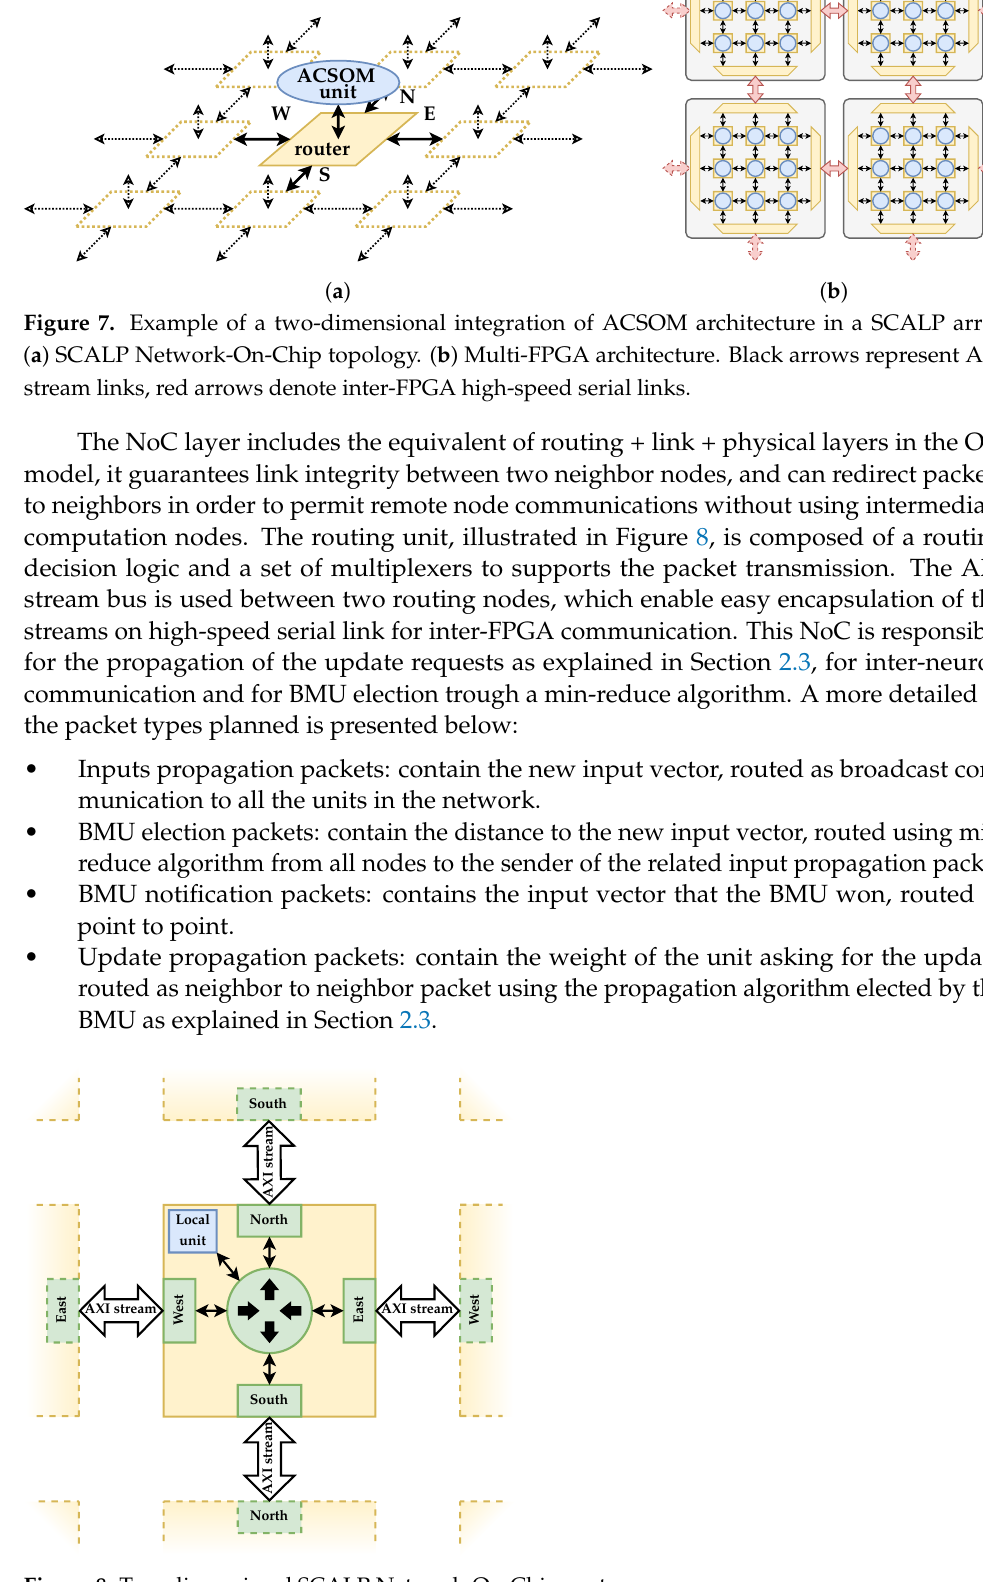
Figure 8. Two-dimensional SCALP Network-On-Chip